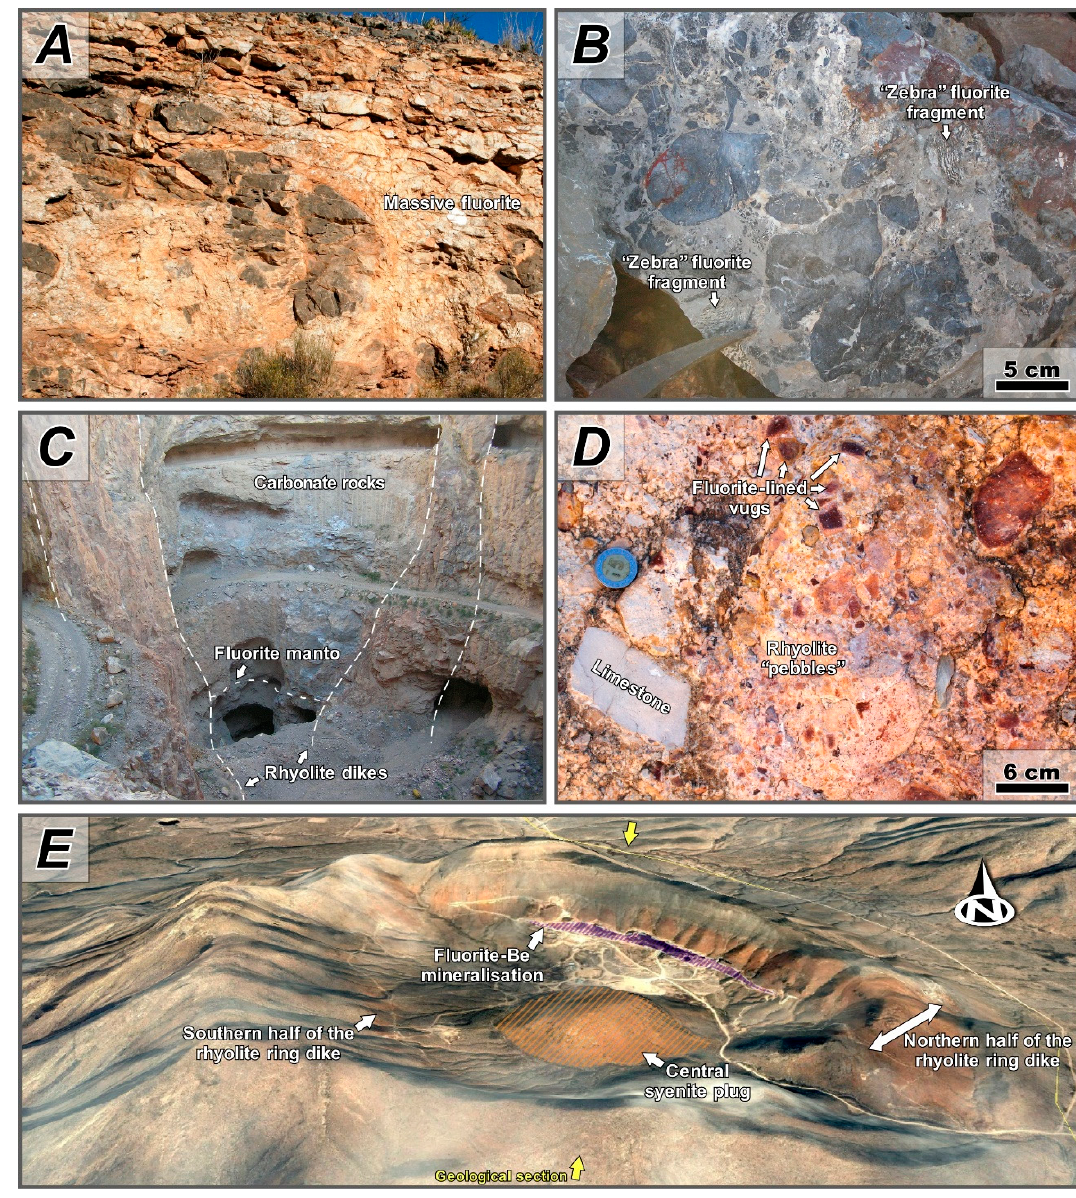
Figure 3. Macroscopic traits of MVT-like fluorite and later fluorite–U–V–Mo–P mineralisation in the Aguachile–Cuatro Palmas area, Coahuila. ( A ) Pendant roof breccia in the upper part of the MVT-like massive and partly banded fluorite mineralisation at the La Fácil deposit. ( B ) Late structural/hydrothermal breccia with host limestones ans zebra-like MVT fluorite mineralisation as fragments at the El Caracol deposit. ( C ) Eocene rhyolite dikes crosscutting MVT-like stratabound fluorite mantos at the El Caracol deposit. ( D ) Pebbly facies on the mineralised shoulder of the northern half of the rhyolite ring dike at the Aguachile deposit; notice the occurrence of purplish fluorite lining cavities. ( E ) Google Earth image of the relief in the Aguachile deposit and its intrusive complex, as of January 2018.